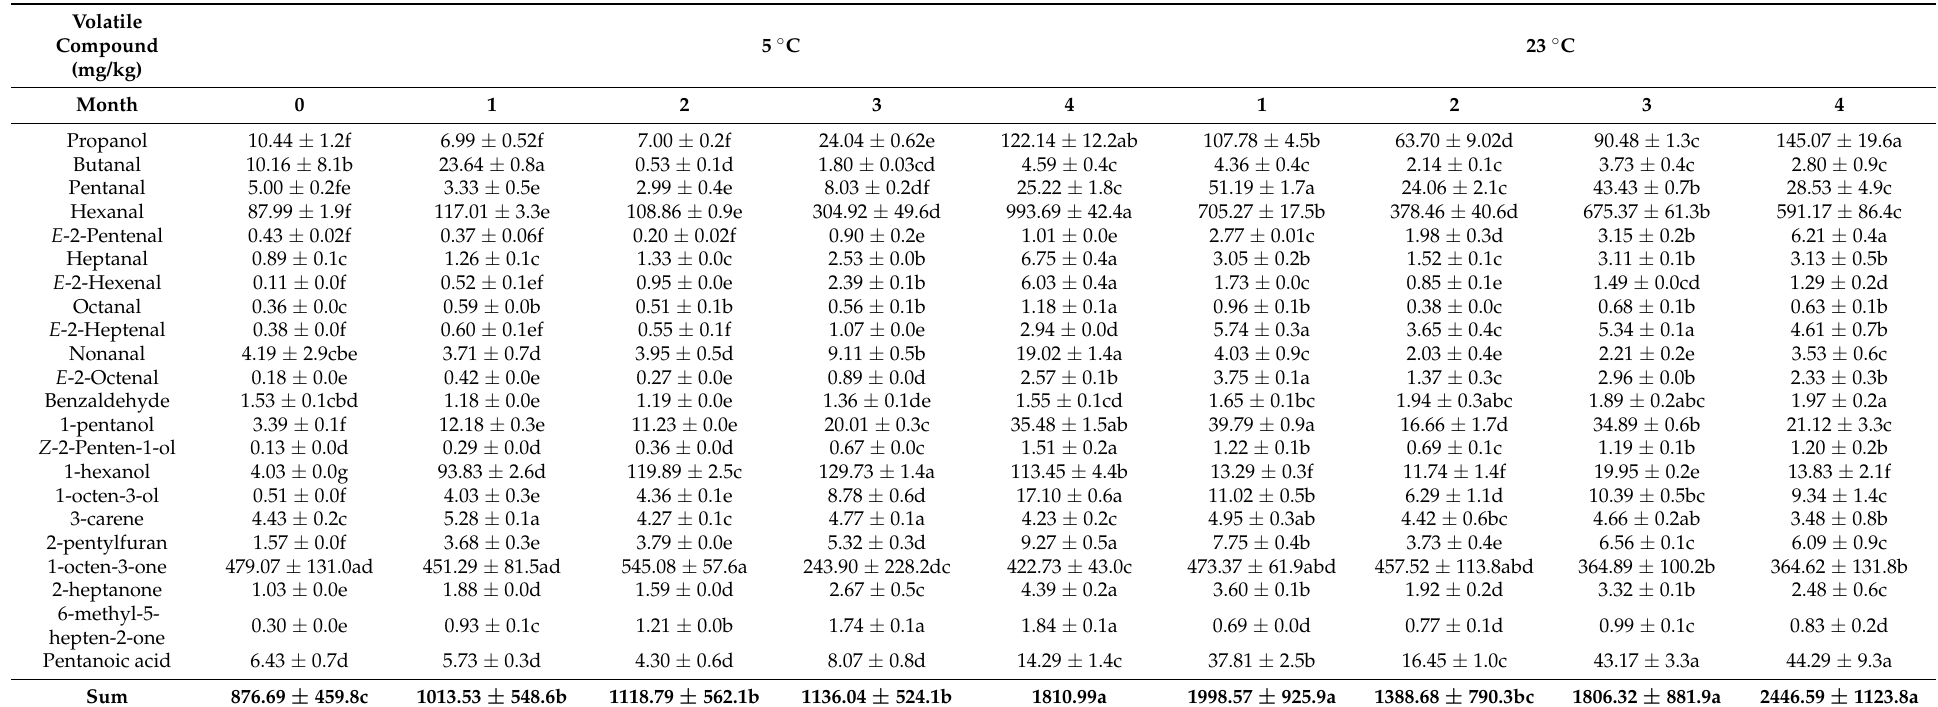
Table 6. Volatile changes in Howard oil during